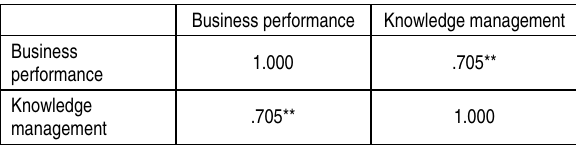
Table 4. Correlation coefficients